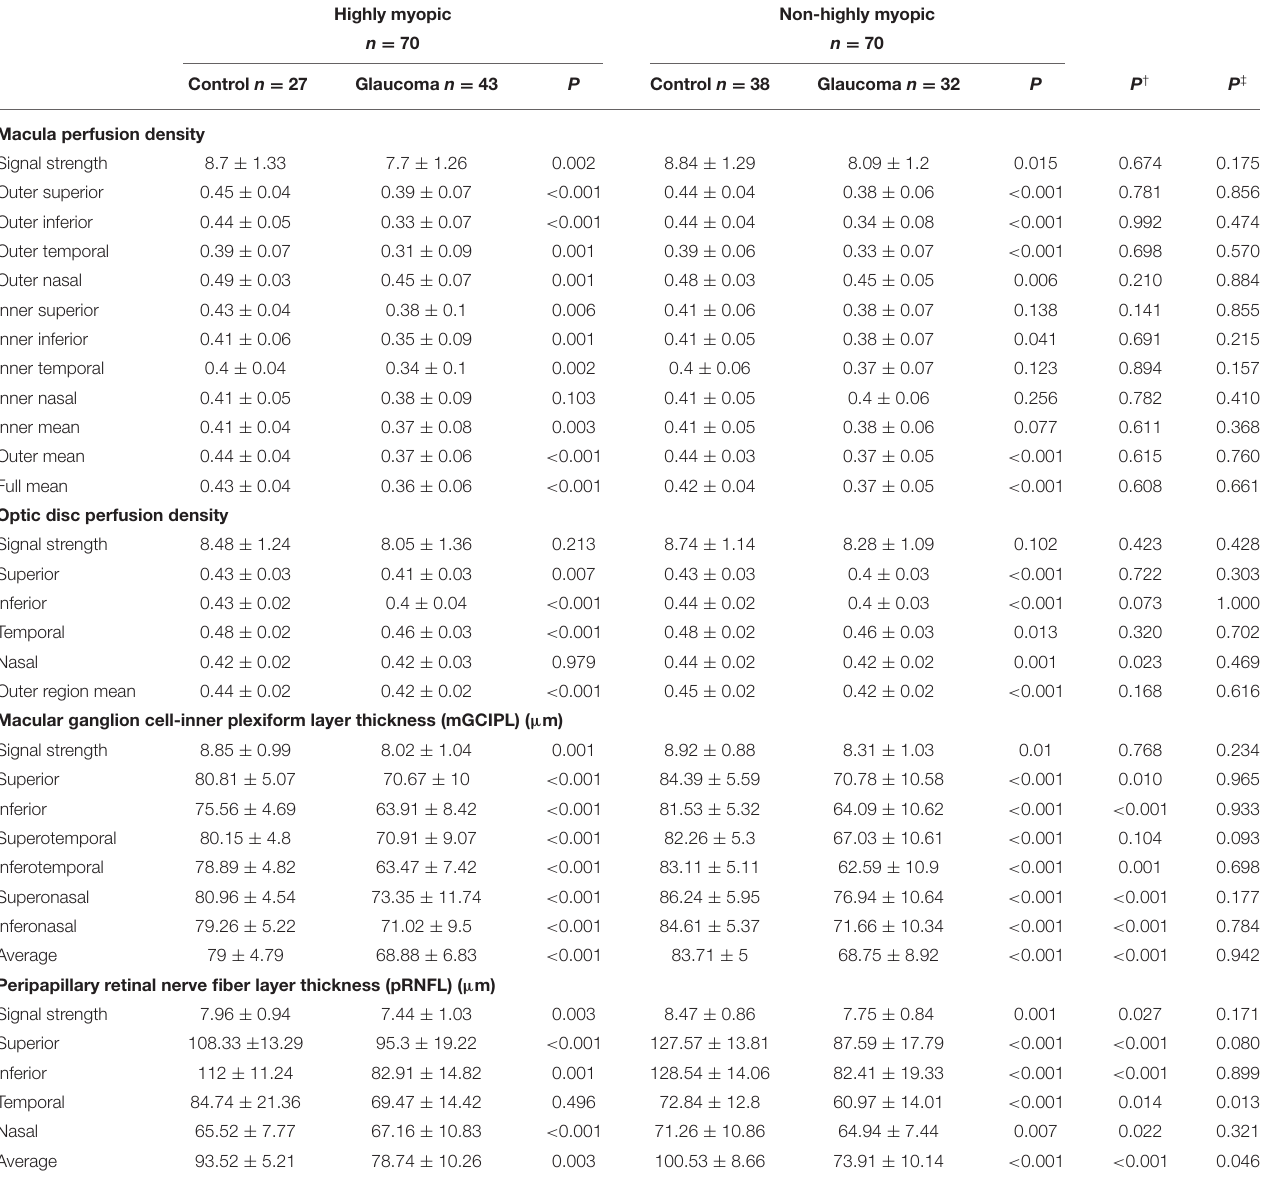
TABLE 2 | Vessel perfusion density parameters measured by optical coherence tomography angiography (OCTA) and structural parameters measured by optical coherence tomography (OCT). Highly